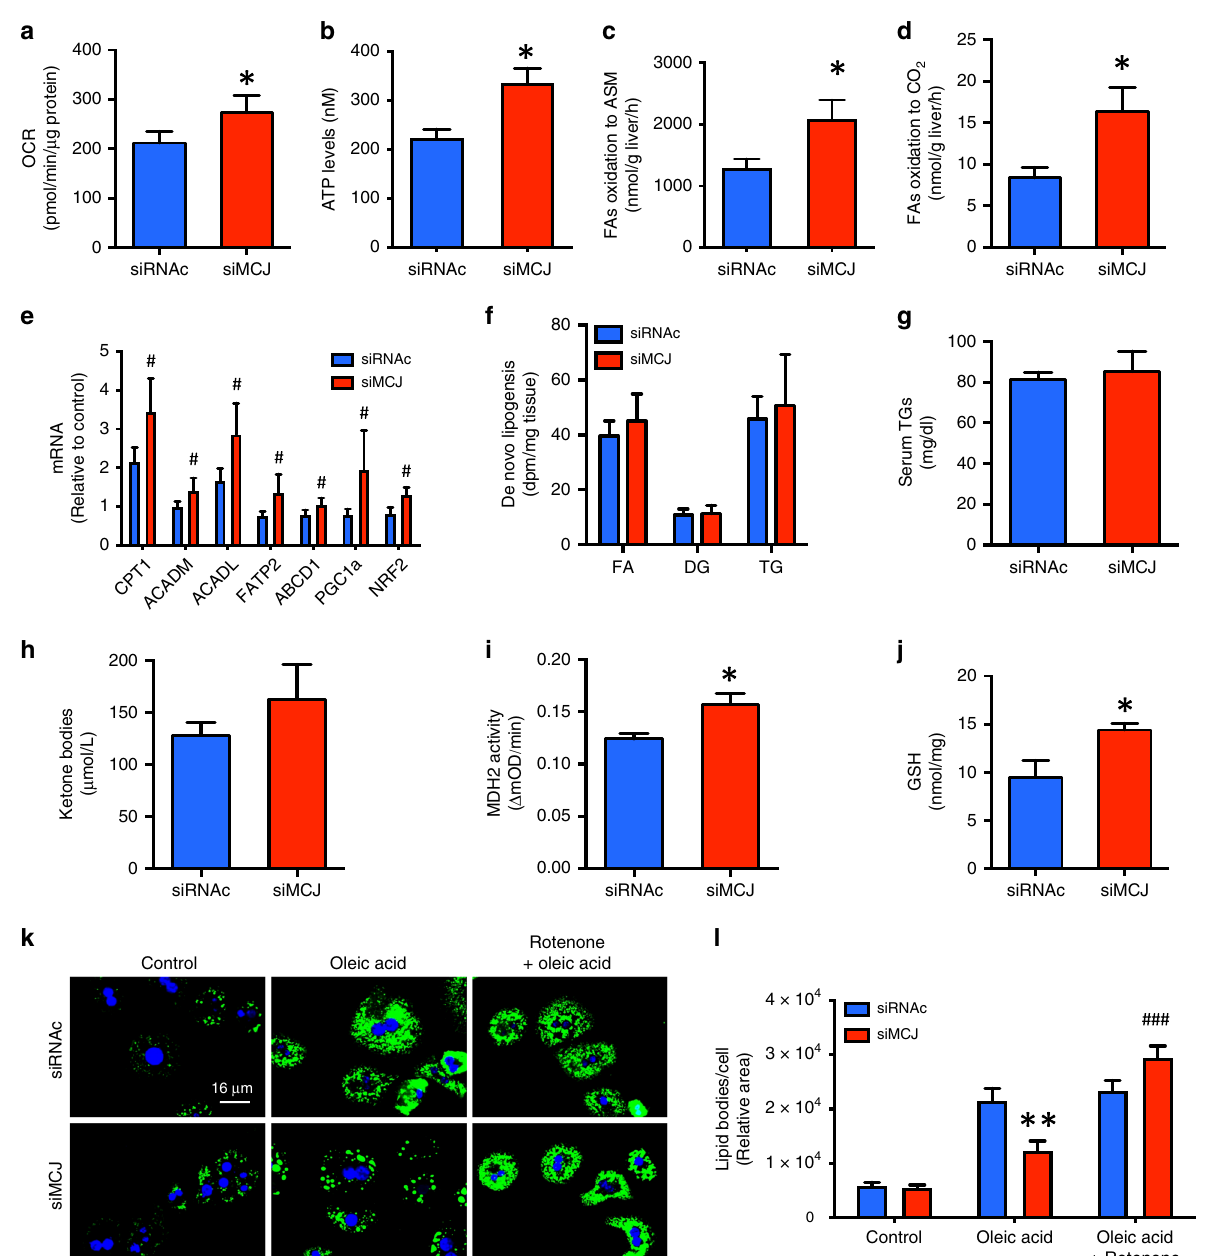
Fig. 5 MCJ silencing enhances β -oxidation and prevents lipid accumulation in hepatocytes in vitro and in vivo. a – j Mice were placed on mMCD diet 1 week prior to the initiation of the treatment and maintained on the diet for the duration of the study. Treatment with Invivofectamine-formulated siMCJ ( n = 5) or siRNAc ( n = 5) was given weekly for 3 weeks. Tissues were harvested 1 week after the last dose. a Oxygen consumption rate (OCR) using the Seahorse analyzer. b ATP levels in isolated mitochondria. c Rate of fatty acid oxidation determined by the production of acid soluble metabolites (ASM). d Rate of fatty acid oxidation determined by the production of CO 2 . e mRNA expression of fatty acid oxidation genes in siMCJ-treated liver relative to control liver, as determined by real time RT-PCR. f De novo lipogenesis of fatty acids (FA), diglycerides (DG), and triglycerides (TG) in the liver. g Triglycerides levels and ( h ) ketone bodies levels in serum. i Activity of malate dehydrogenase (MDH2) in liver extracts. j Glutathione (GSH) levels in liver. k - l Primary hepatocytes from WT mice were transfected with siRNAc or siMCJ and were incubated with steatosis-inducing doses of oleic acid alone for 24 h or in combination with rotenone for the last 6 h. k Representative images of lipid content and ( l ) quanti fi cation evaluated by Bodipy staining. *denotes p < 0.05, as determined by Student ’ s t test analysis. Error bars show standard error (SE) in all the panels except panels ( e ) and ( f ) where error bars show standard deviation (SD). Source data are provided as a Source Data fi